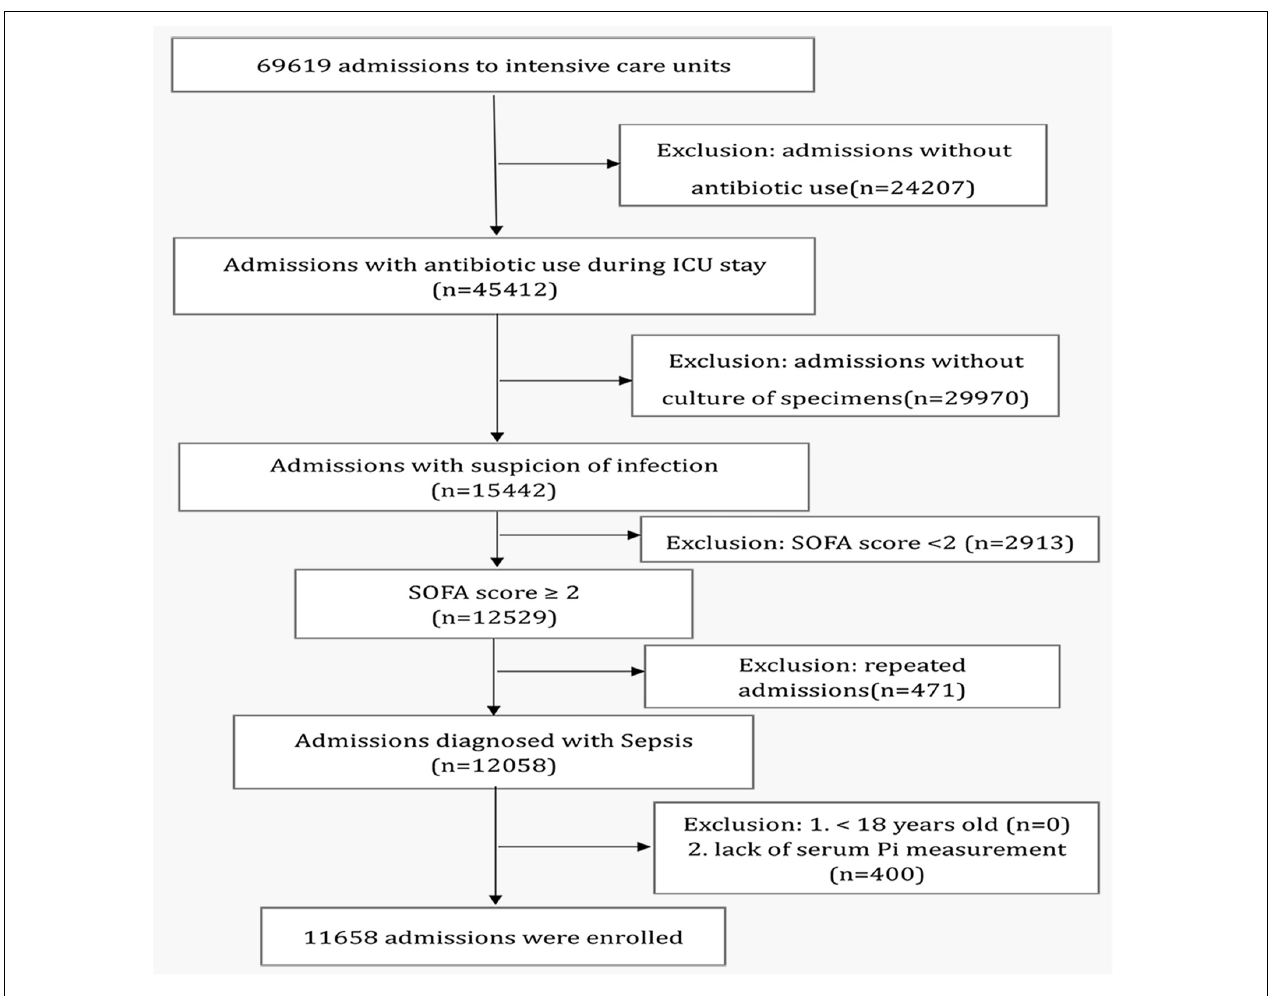
FIGURE 1 | Study flowchart. ICU, intensive care